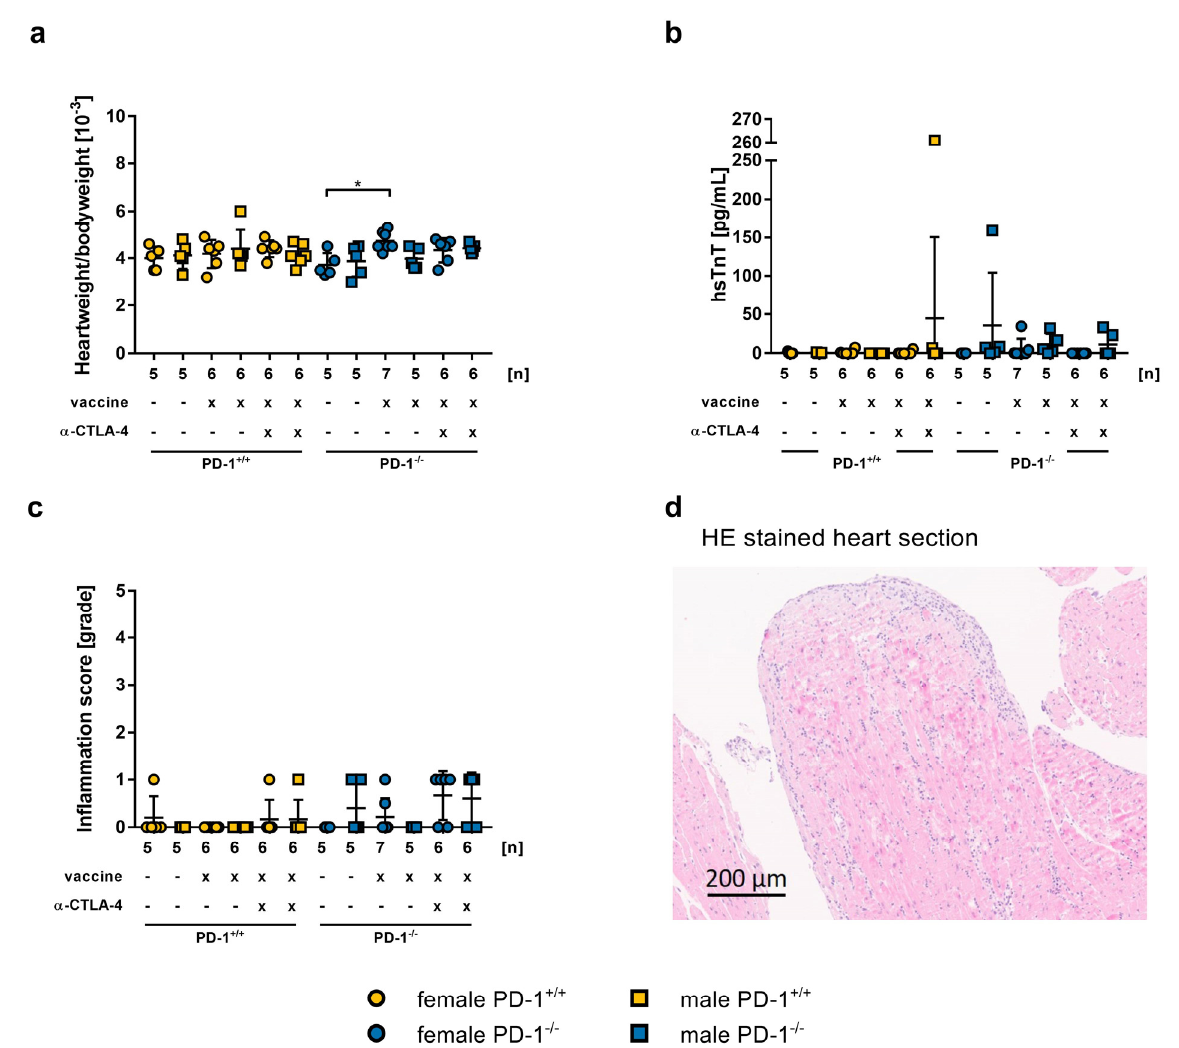
Figure 6. Impact of 2.5 µ g mRNA-vaccine on BL/6 PD − 1 +/+ and BL/6 PD-1 − / − in combination with immune inhibition. Data is presented as a mean ± SEM (PD − 1 +/+ untreated n = 5, vaccine n = 6, vaccine + aCTLA-4 n = 6; PD-1 − / − untreated n = 5, vaccine female n = 7, male n = 5, vaccine + aCTLA-4 n = 6). ( a ) Heart weight to body weight ratio on day 42 . Statistical significance was determined by t-test, * p = 0.0029. ( b ) Determination hsTnT-levels of mouse serum collected on day 42 . ( c ) Histopathological examination of inflammation score in grades in HE stained heart sections on day 42, evaluated by two independent investigators. ( d ) Inflamed heart section of a BL/6 PD-1 − / − mouse after vaccination and anti-CTLA-4